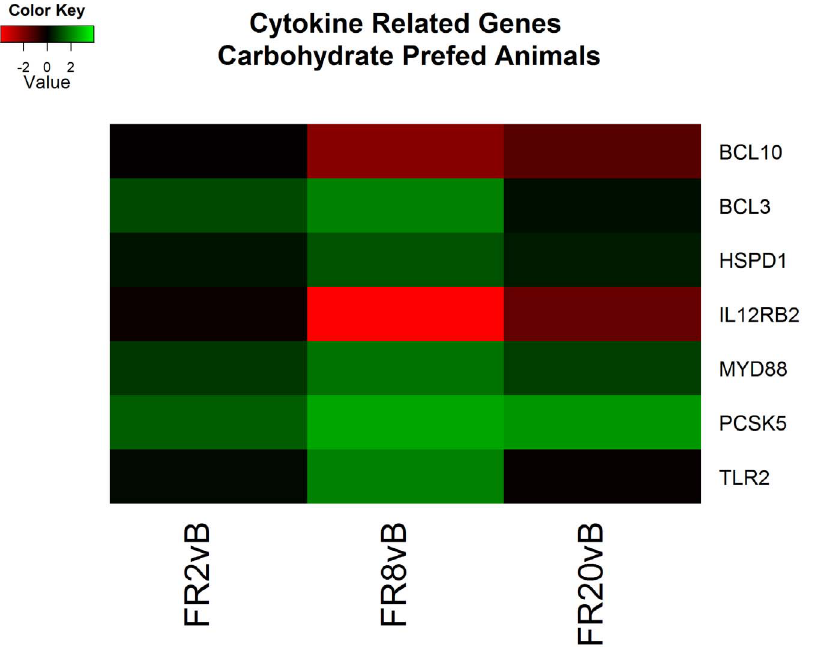
Figure 4. Heatmap of log2 fold changes of genes associated with cytokine related genes in carbohydrate prefed (CPF) animals at each resuscitation timepoint (2, 8, and 20 hours) relative to Baseline (B). Rows are differentially expressed genes (DEGs) following RNA sequencing. Columns denote the respective timepoints Baseline (B), 2 hours full resuscitation change from Baseline (FR2vB), 8 hours full resuscitation change from Baseline (FR8vB), and 20 hours full resuscitation change from Baseline (FR20vB). Green denotes increased mRNA expression with respect to Baseline whereas red denotes the opposite.